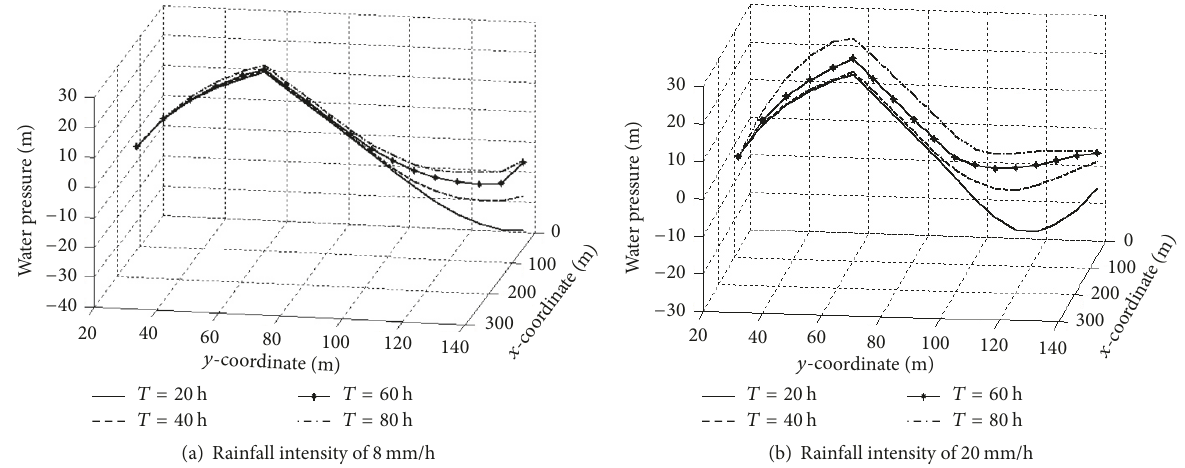
Figure 10: Pressure head contours on fault considering rain falling